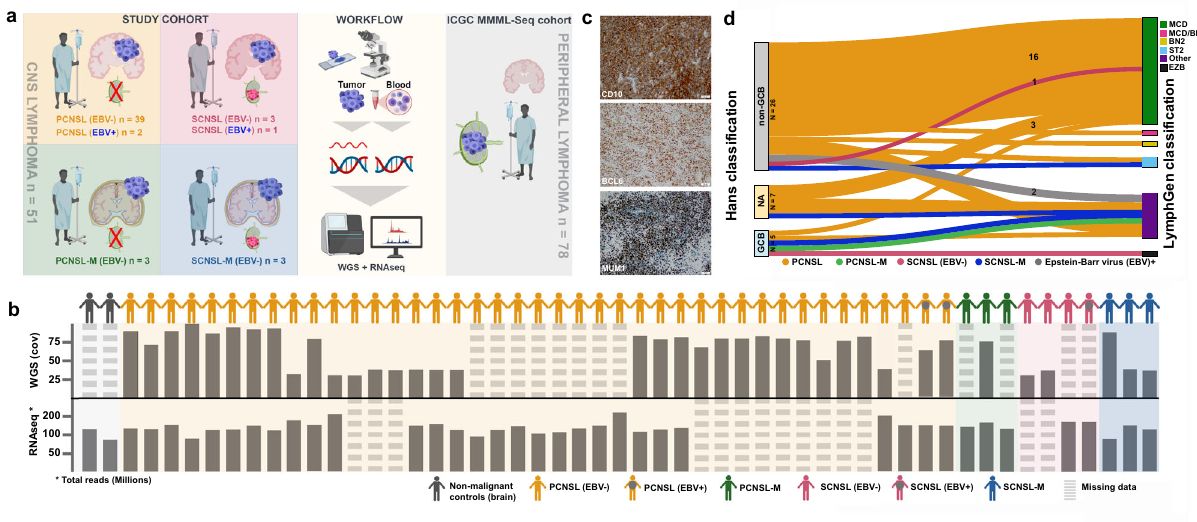
Fig. 1 Study design and multi-omic analysis of the CNSL cohort. Panel a demonstrates the study design, study cohort along with sample size, and sequencing approach. The central nervous system lymphoma (CNSL) cohort consists of 51 primary and secondary lymphoma (PCNSL and SCNSL) patients. Whole-genome sequencing was performed using tumor tissue and matched peripheral blood samples. For RNA sequencing, we additionally analyzed normal controls (non-malignant brain tissue (frontal lobe)) and included data from peripheral lymphomas without CNS manifestation for validation (ICGC MMML-seq cohort). The lower panel b lists all CNS lymphoma derived from PCNSL or SCNSL patients as well as controls. The depth of coverage (cov) for whole-genome sequencing and total number of reads in RNA sequencing are given for each tumor sample. Whole-genome sequencing data were obtained from n = 38 PCNSL/SCNSL patients. RNA sequencing data was generated from n = 37 PCNSL/SCNSL patients and n = 2 normal controls. In 24 PCNSL/SCNSL cases, we obtained patient-matched whole-genome and RNA sequencing data. Striped bars indicate data sets missing for individual samples. The CNSL specimen were examined according to the Hans classi fi cation (CD10, BCL6, and MUM1 ( c )). Additionally, we classi fi ed all n = 38 whole-genome sequencing CNSL samples according to the genetic DLBCL subtypes using the LymphGen algorithm as described by Wright et al., 2020 ( d ). The results are displayed in a Sankey plot. Images in panels a and b were partially created with